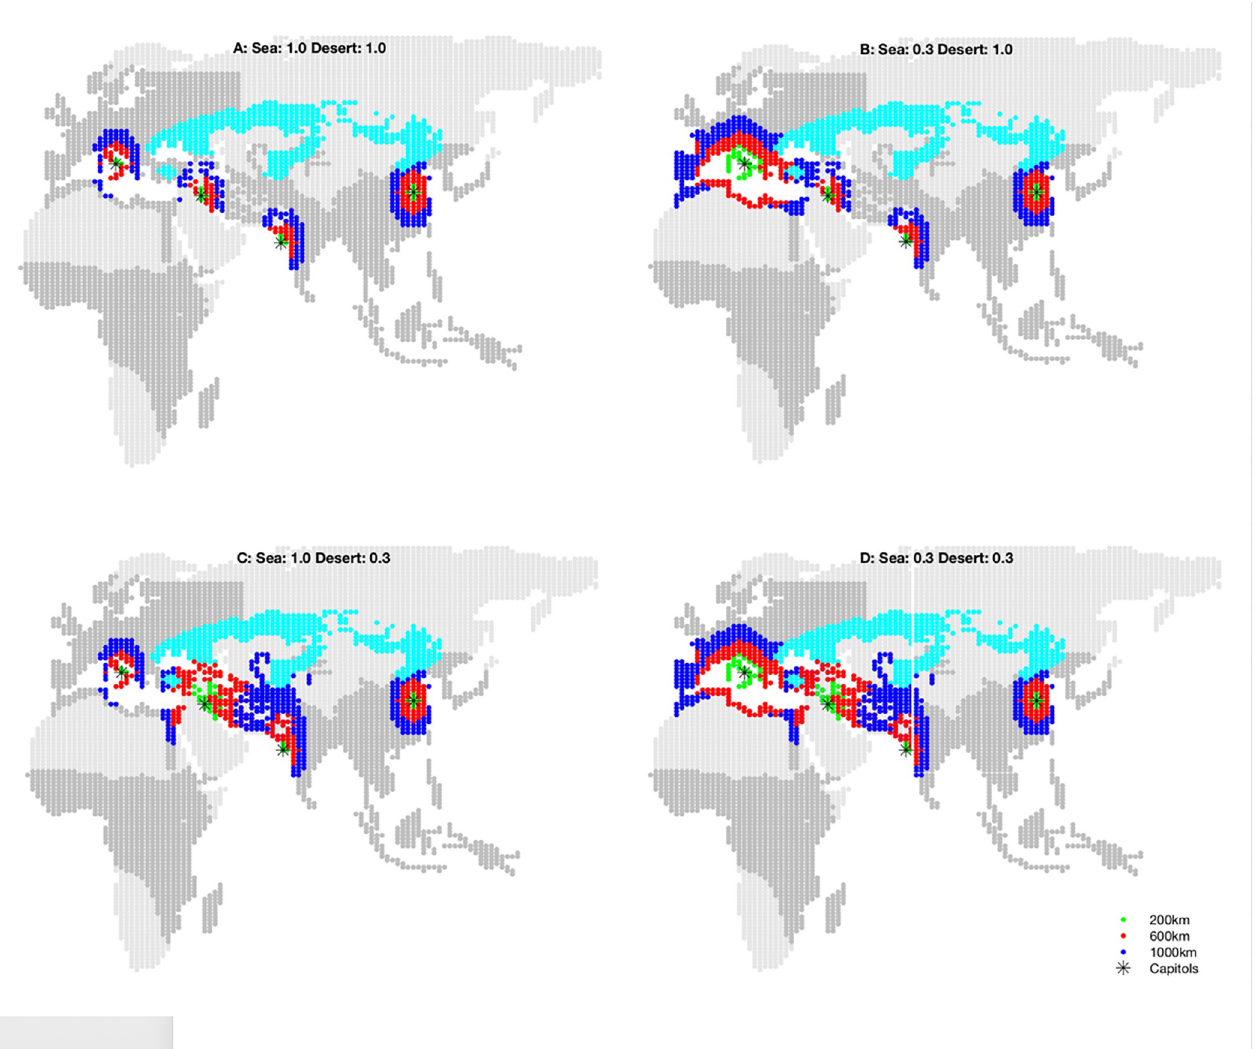
Fig 7. Effective military distances. Effective military distance to agricultural regions (dark grey) from four ‘capitols’ (Rome, Babylon, Mumbai, and Beijing) under different discount factors for long-distance sea and desert travel. Colors indicate how distant ‘200 km’ (green) ‘600 km’ (red) and ‘1000 km’ (blue) appear for given a set of efficiency factors. Darker grey indicates agricultural regions; light blue indicates steppe. Map data republished from [16] under a CC BY license, with permission from Proceedings of the National Academy of Sciences, original copyright 2013. As Beijing enjoys no sea or desert travel advantage its distances remain unchanged in each panel. A : No travel advantage; the distances from the western capitals resemble Beijing’s. B : Mediterranean sea travel discounted to 30% of normal overland travel; Rome is able to reach territories along the lip and deep into Europe; Babylon has some access. C : Near East desert travel discounted to 30% of normal overland travel allows Babylon and Mumbai to interact with one another if powerful enough. D : Combined discounted Mediterranean and Near East travel, used in the nominal simulation.